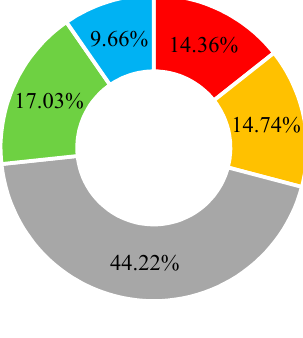
Figure 2. Expectations towards the use of public transport post-pandemic.